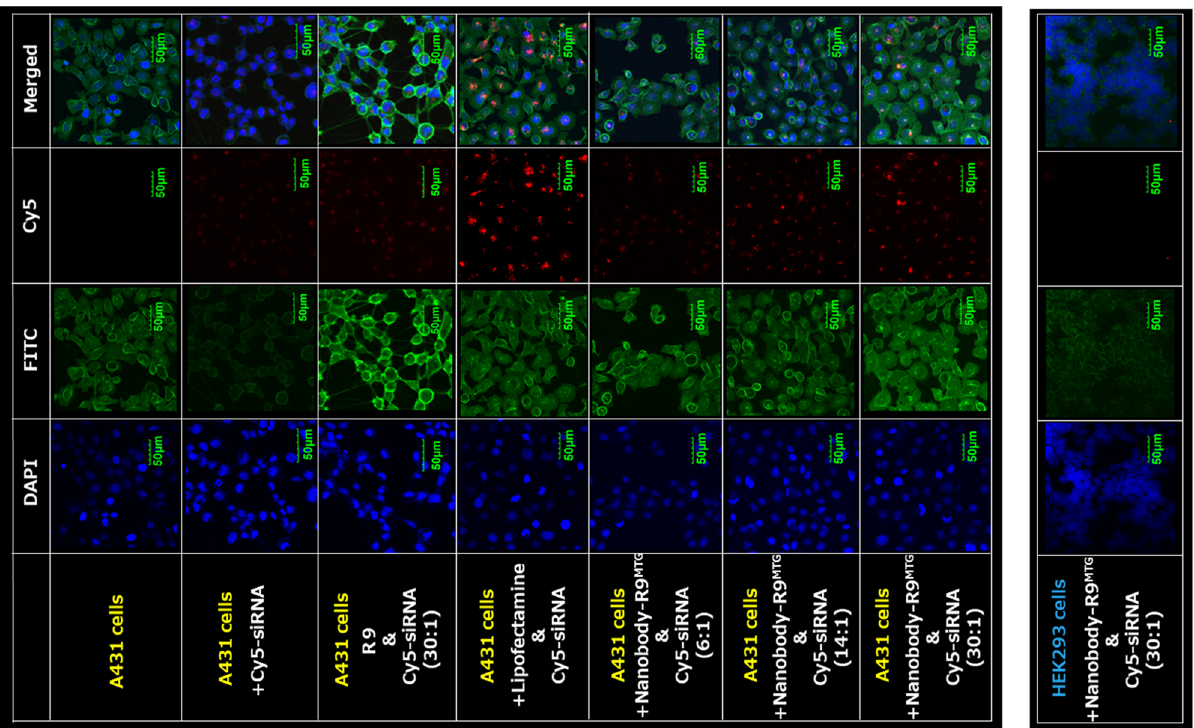
Figure 6. Delivery of siRNA by Nanobody-R9 MTG into A431 cells. EGFR positive cells (A431) were mixed with Nanobody-R9 MTG -Cy5 siRNA. Cell nuclei and membranes were stained with DAPI and Cell Mask™ Green Plasma Membrane stain. The fluorescence of the cells after the reaction was observed using a confocal microscope. HEK293 cells were used as EGFR negative cell. Lipofectamine is used as positive control.